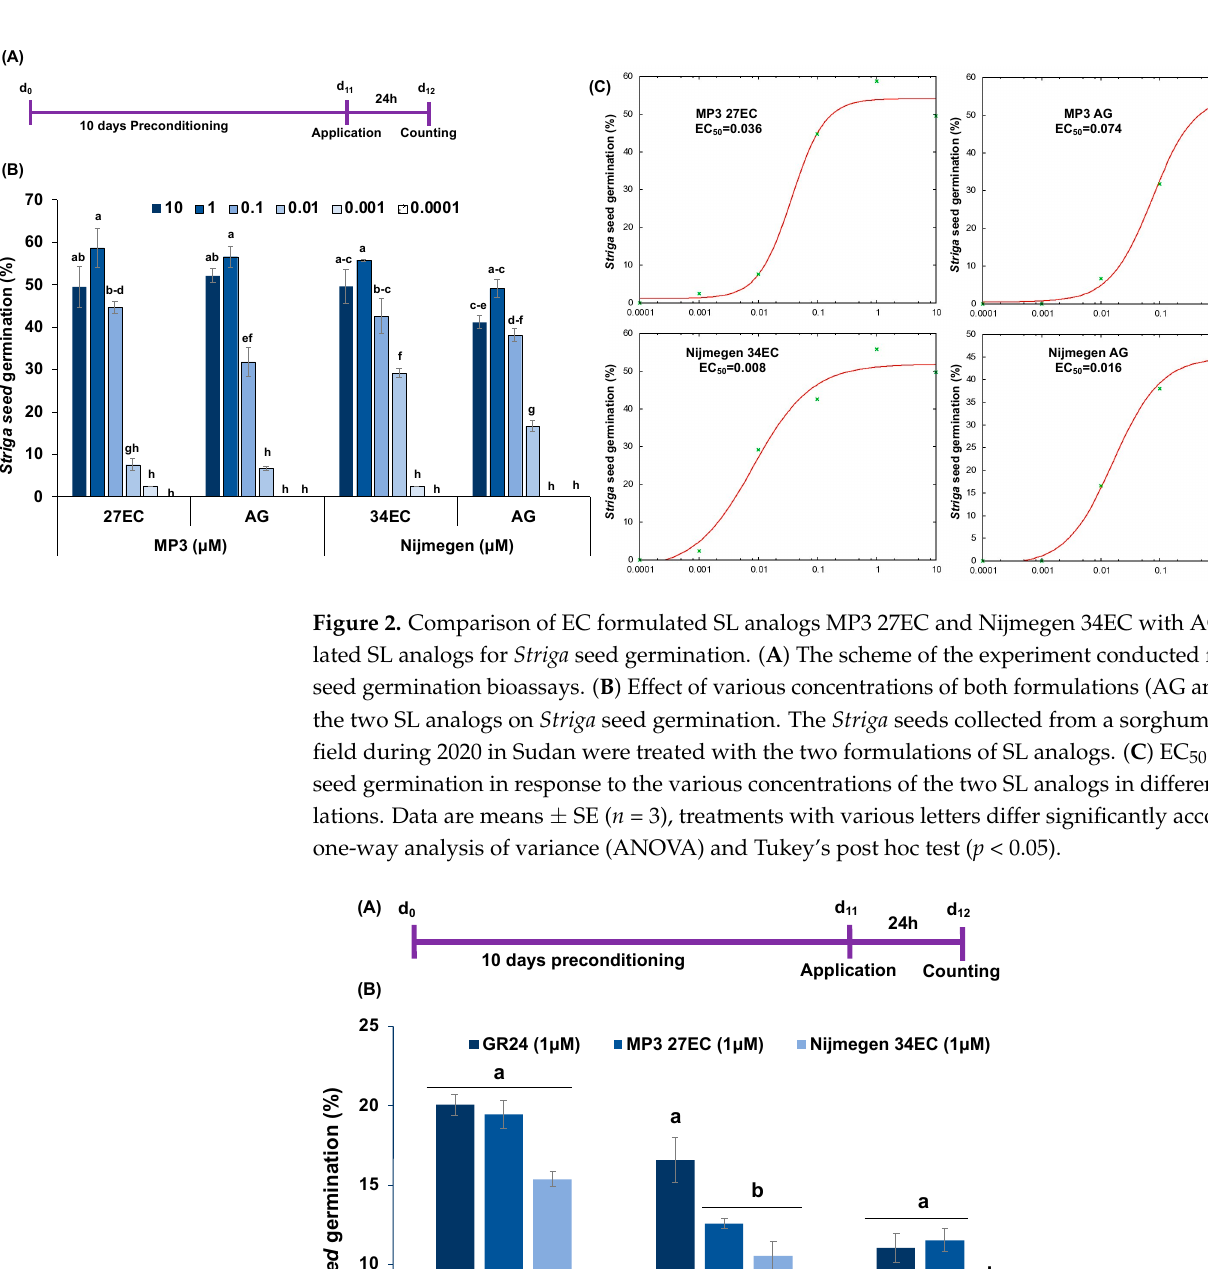
Figure 1. Structure of selected SL analogs and packaging of Emulsifiable Concentrate (EC) formu-